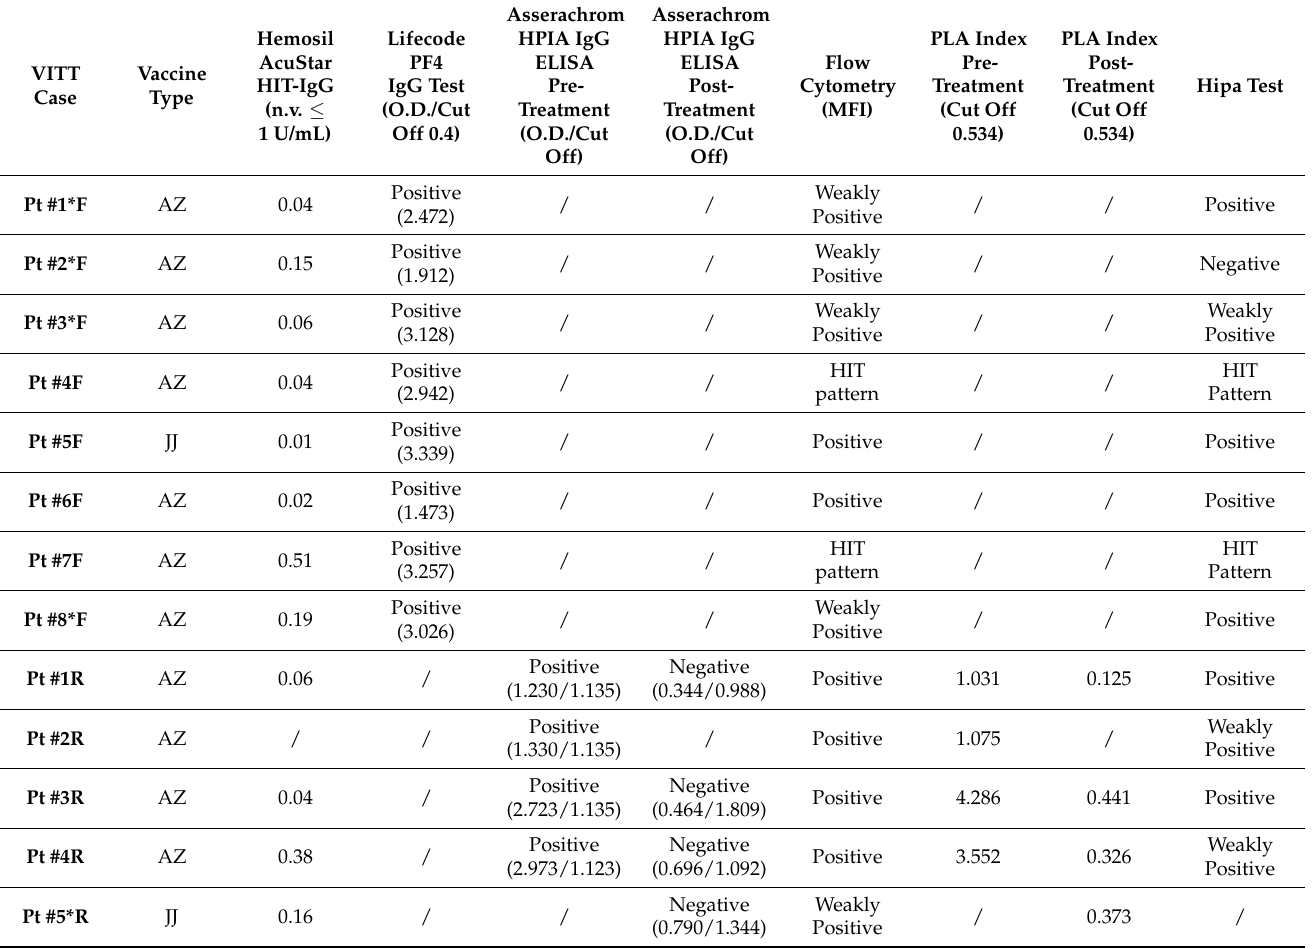
Table 2. Results of immunological and functional tests in VITT patients. * Patients analyzed under IvIg